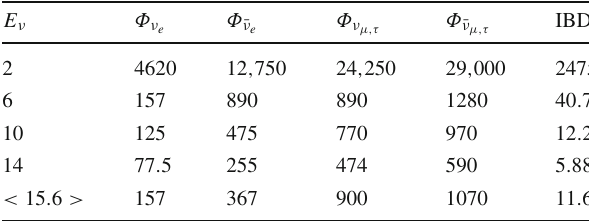
Table 1 Upper limits on fluences per single FRB for all neutrino fla- vors obtained from the temporal correlation analysis in 10 9 cm − 2